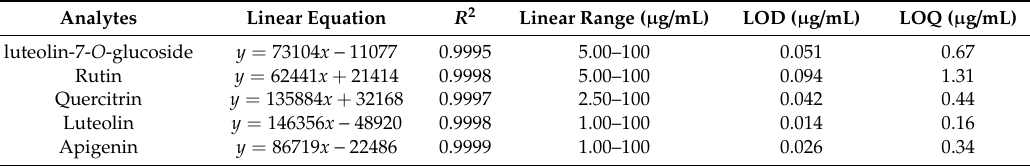
Table 3. Linear regression, limit of detection (LOD), and limit of quantification (LOQ) of the five tested compounds.